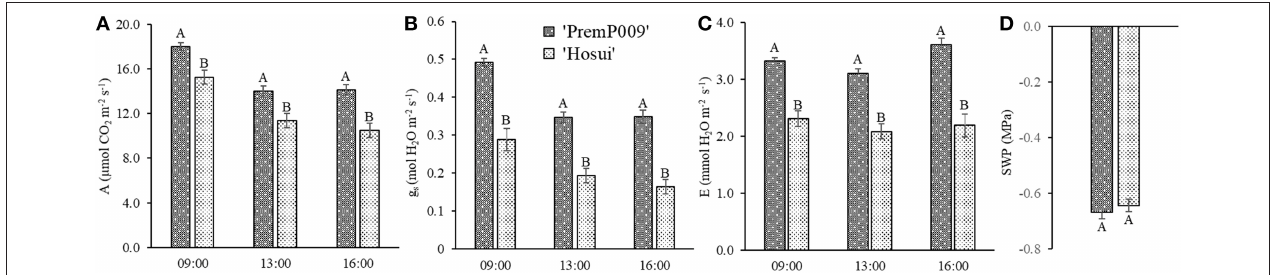
FIGURE 4 | Mean ( ± Standard Error, SE) net photosynthesis (A) (A) , stomatal conductance (g s ) (B) , transpiration (E) (C) at 9:00, 13:00, and 16:00 on 2015 January 15th, and midday stem water potential (SWP) (D) for the two genotypes. Each bar represents the mean ± SE of four replicates of the three plant types.